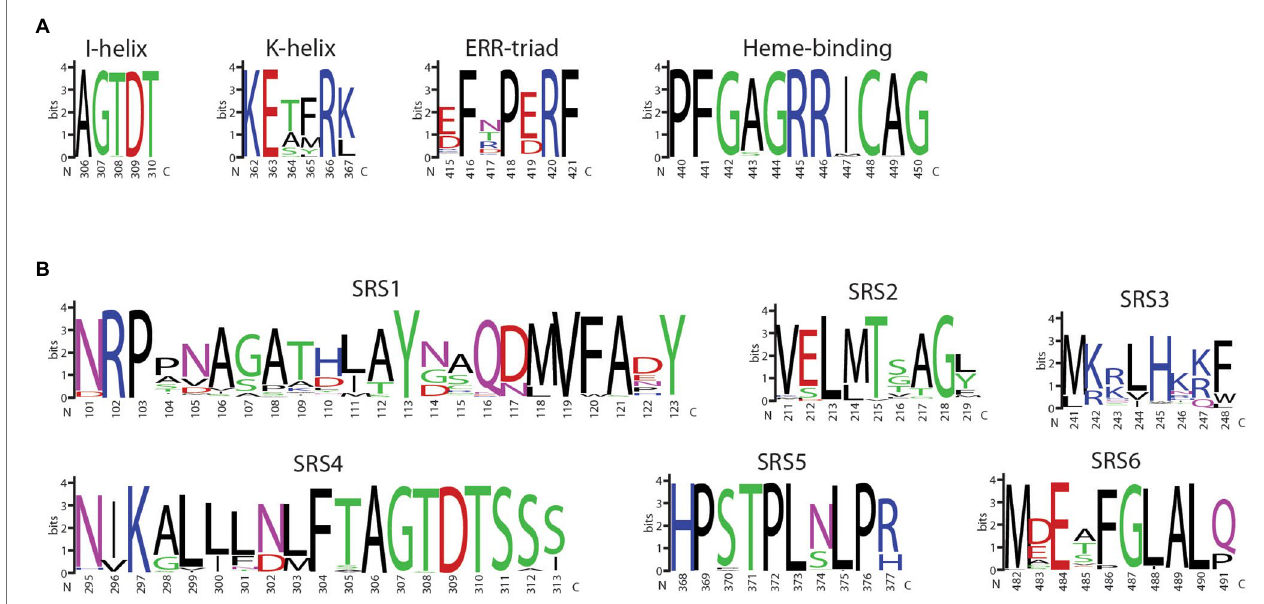
FIGURE 6 | WebLogo display of the (A) four core CYP450 motifs and (B) six sequence recognition sequences (SRS) of land plant flavonoid 3 ′ 5 ′ hydroxylase proteins. The logos are based on the multiple sequence alignment using MUSCLE of 177 land plant F3 ′ 5 ′ H protein sequences identified from an exhaustive search of Phytozome and NCBI protein databases. The amino acid positions are based on the sequence of 5-593 of P. vulgaris .